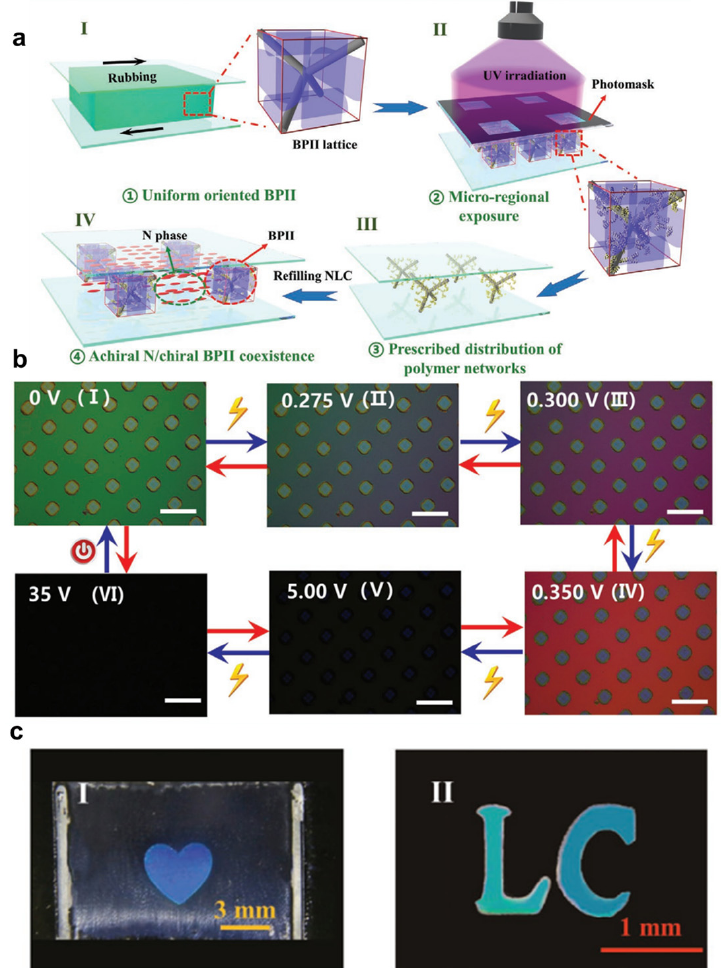
Figure 12. ( a ) Schematic diagram of the patterned soft coexistence of optically non-chiral aniso- tropic N phase and optically chiral isotropic BPII by local micro-regional polymer template tech- nique; ( b ) reflected POM image of two phases coexisting at different applied voltages; ( c ) reflected image of two phases coexisting [110]. Reversible On–Off of Chirality and Anisotropy in Patterned Coexistence of Achiral-Anisotropic and Chiral-Isotropic Soft Materials from Mo, Advanced Optical Materials, published by John Wiley and Sons.